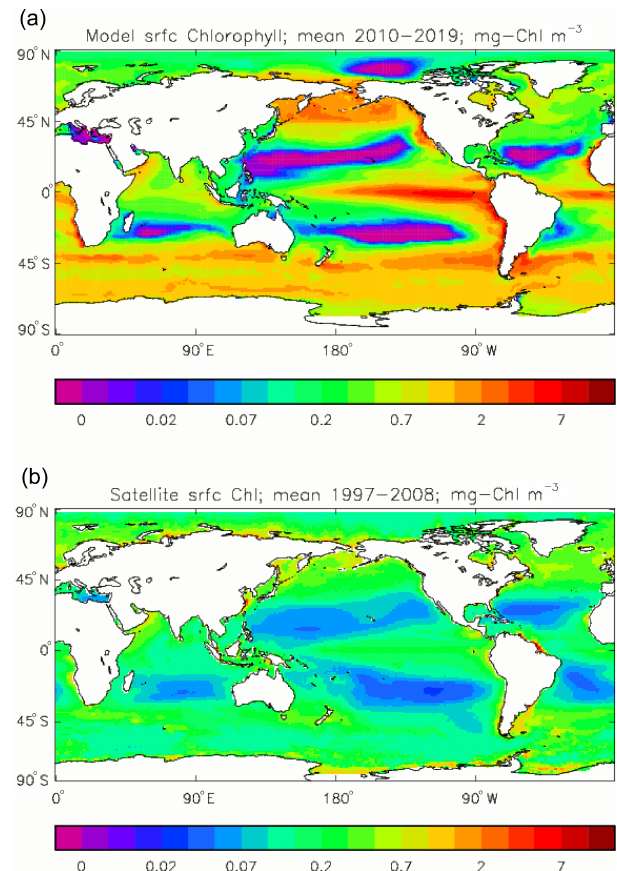
Figure 2. Comparison of surface chlorophyll: (a) mean over the years 2010–2019 from the model, historical + RCP8.5 scenario; (b) mean over 1998–2007 from GlobColour, with further process- ing as described in Ford et al. (2012) (mgChlm − 3